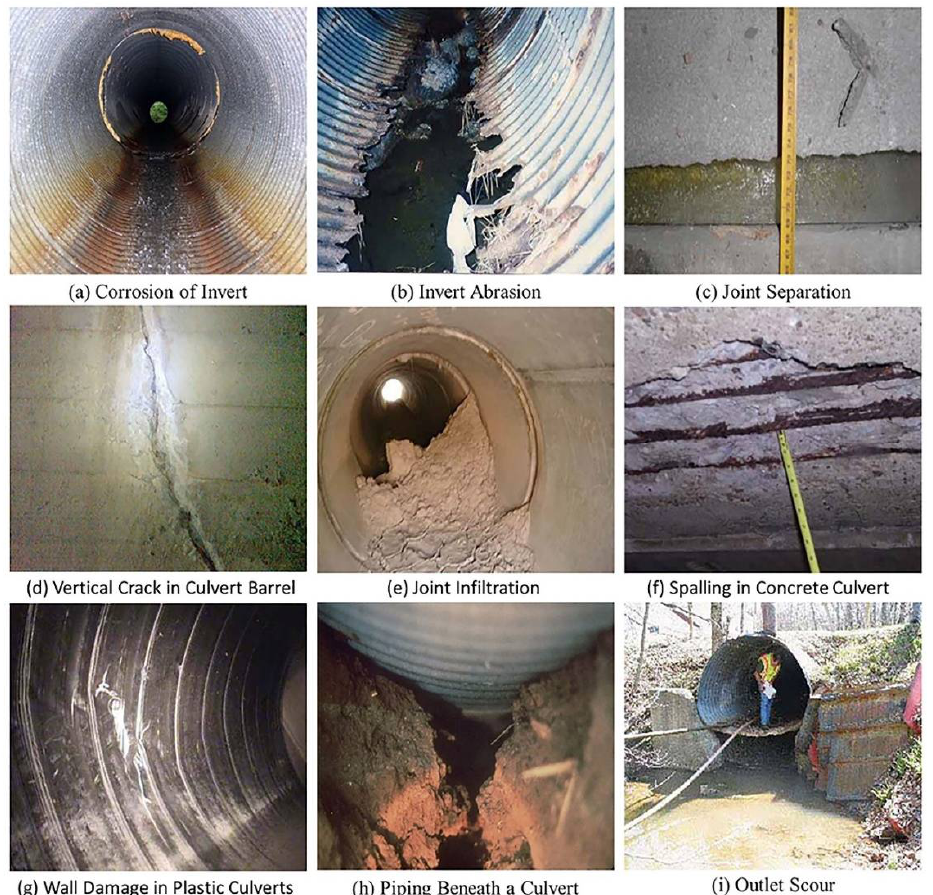
Figure 1. Common defects observed in culverts.